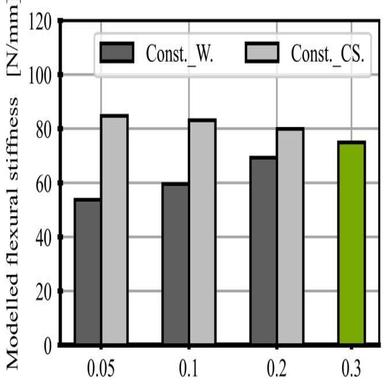
Analytically modelled flexural stiffness of 2D plate induced by thin towpreg with constant width (Const._W.) of 0.3 mm and constant cross-section (Const._CS) of 3.45 mm2 .